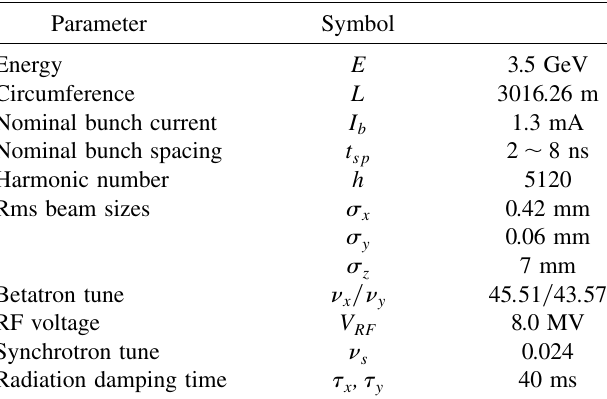
TABLE I. Basic parameters of the KEKB